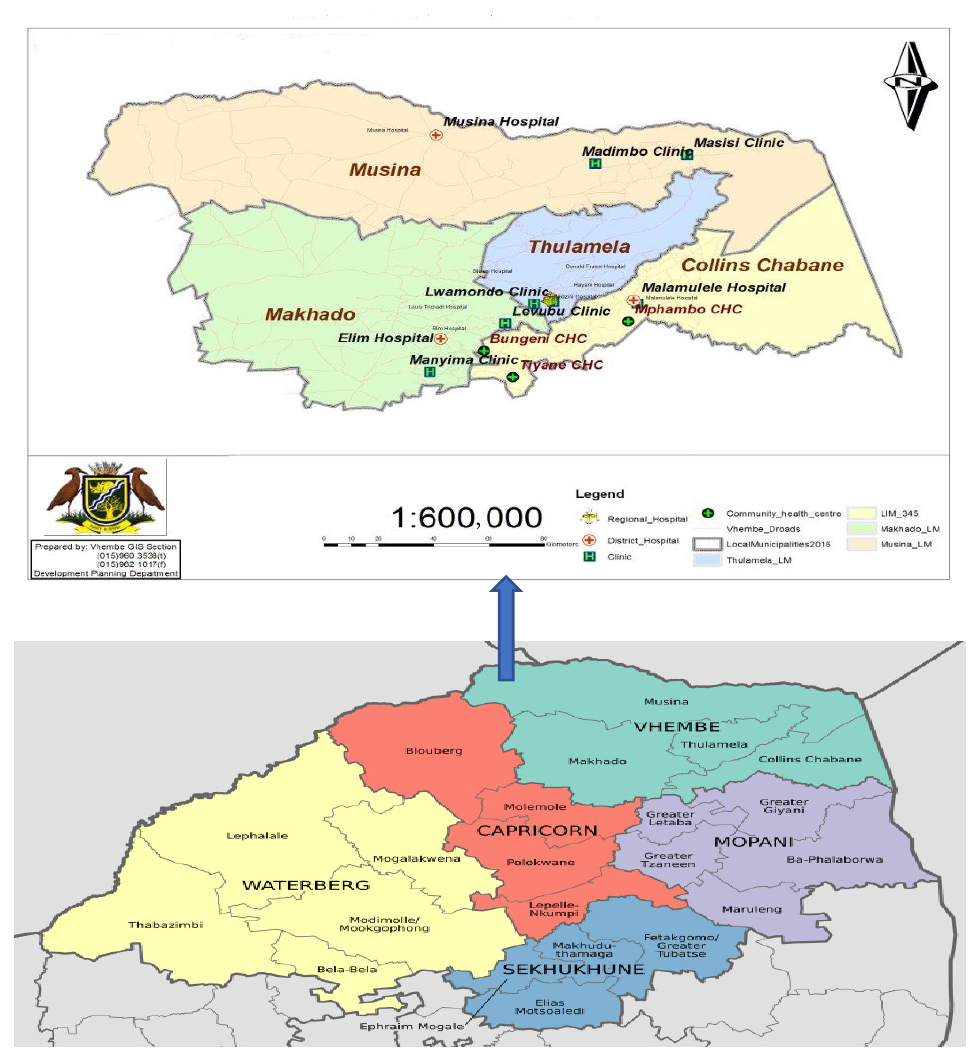
Figure 1. Map of Vhembe District in Limpopo Province showing the study areas.